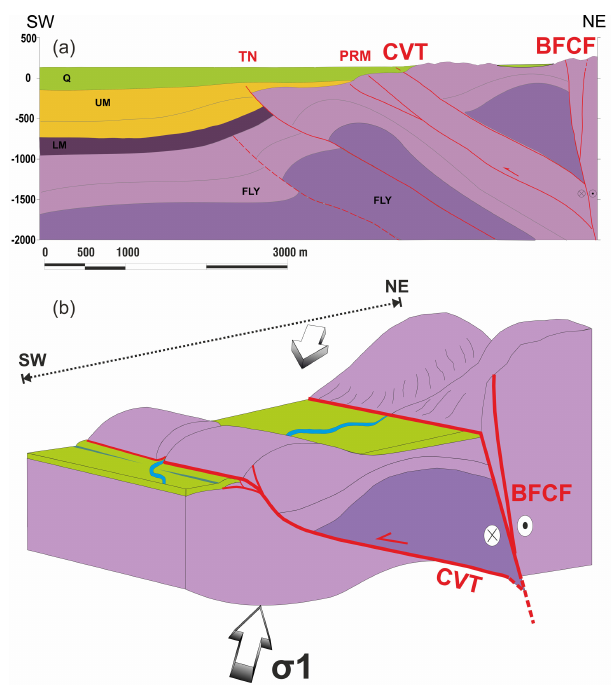
Figure 7. Geological cross section based on the seismic line of Fig. 2 (AA (cid:48) in Fig. 1b) and 3-D scheme (b) of the BFCF- CVT system. Q: Quaternary; UM: Middle–Upper Miocene Mo- lasse; LM: Cavanella Group (Lower–Middle Miocene); FLY: Upper Cretaceous–Lower Eocene turbiditic sequence. TN: Tarnovo nappe front (according to Placer et al., 2010).